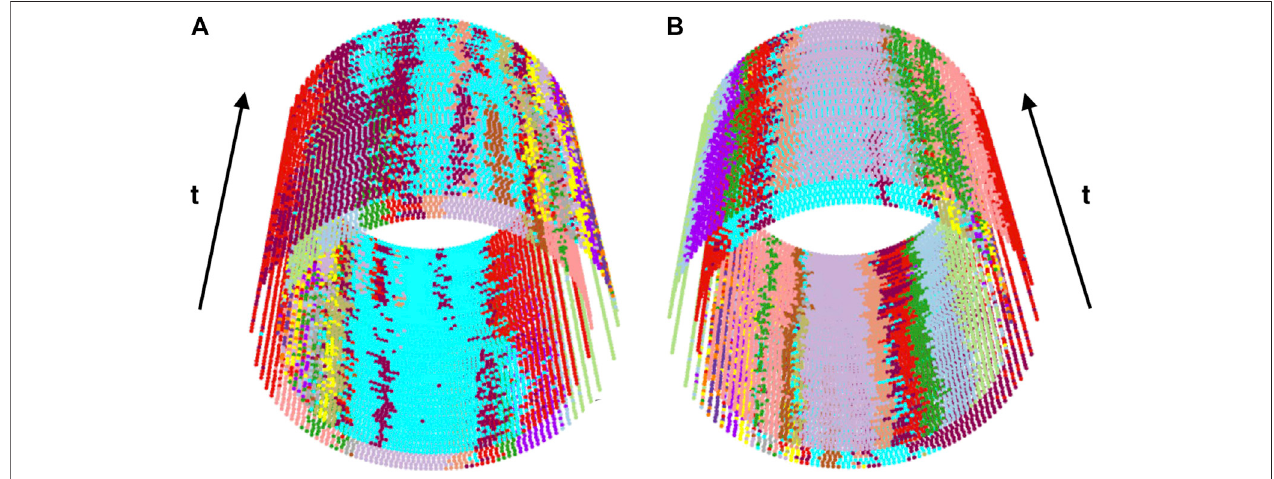
FIGURE 8 | Two angle-views of 3D passtensor constructed from subject #5 ’ s treadmill walking with slope changes in the middle of the temporal period in t . The slope changes cause very subtle change on (A) .